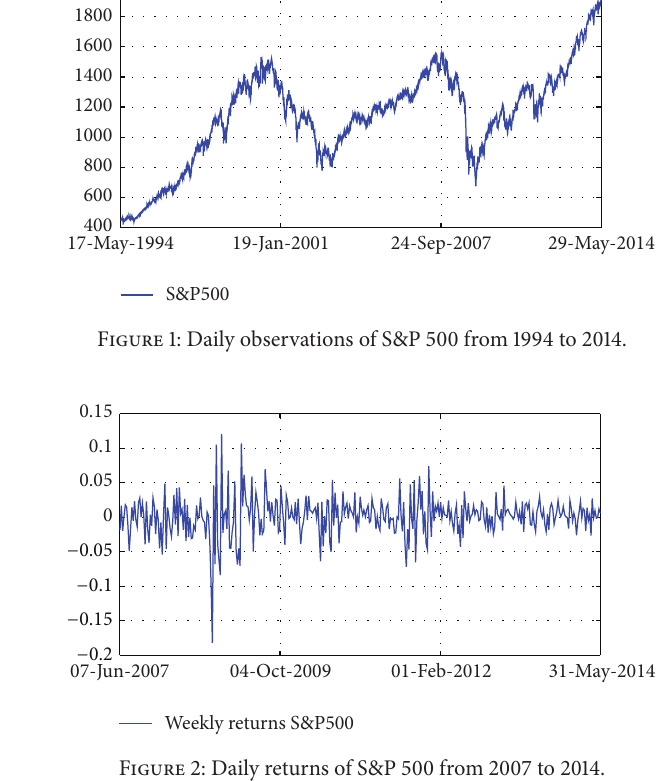
Figure 2: Daily returns of S&P 500 from 2007 to